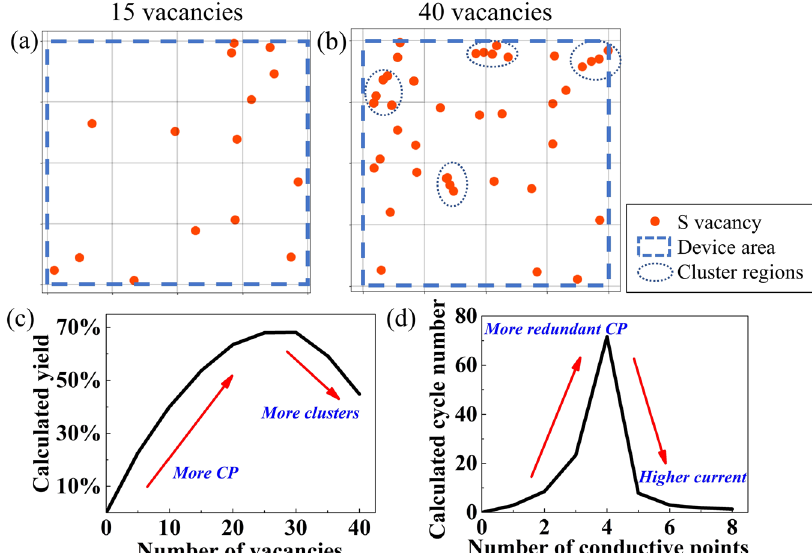
Fig. 8 Monte Carlo simulations to illustrate the irradiation effect on reliability. Representative distribution of sulfur vacancy within the device area with ( a ) 15 vacancies and ( b ) 40 vacancies shown in top view. The vacancies are randomly located in the device area. More vacancies will lead to a higher possibility of clusters formation in the fi lm, which is assumed to reduce the yield due to severe leakage through these clusters that short the electrodes through the MoS 2 . c The calculated yield using Monte Carlo simulation to illustrate two mechanisms that affects device yield: at low radiation dose, yield increases as vacancy number increases due to more (virtual) conductive points formed; at high radiation dose, yield decreases as vacancy number increases due to more clusters formed. d The calculated cycle number using Monte Carlo simulation to illustrate two mechanisms that affect device endurance: at low radiation dose, cycle number increases as conductive point number increases due to more redundant conductive points available; at high radiation dose, cycle number decreases as conductive point number increases due to excessive Joule heating induced by high